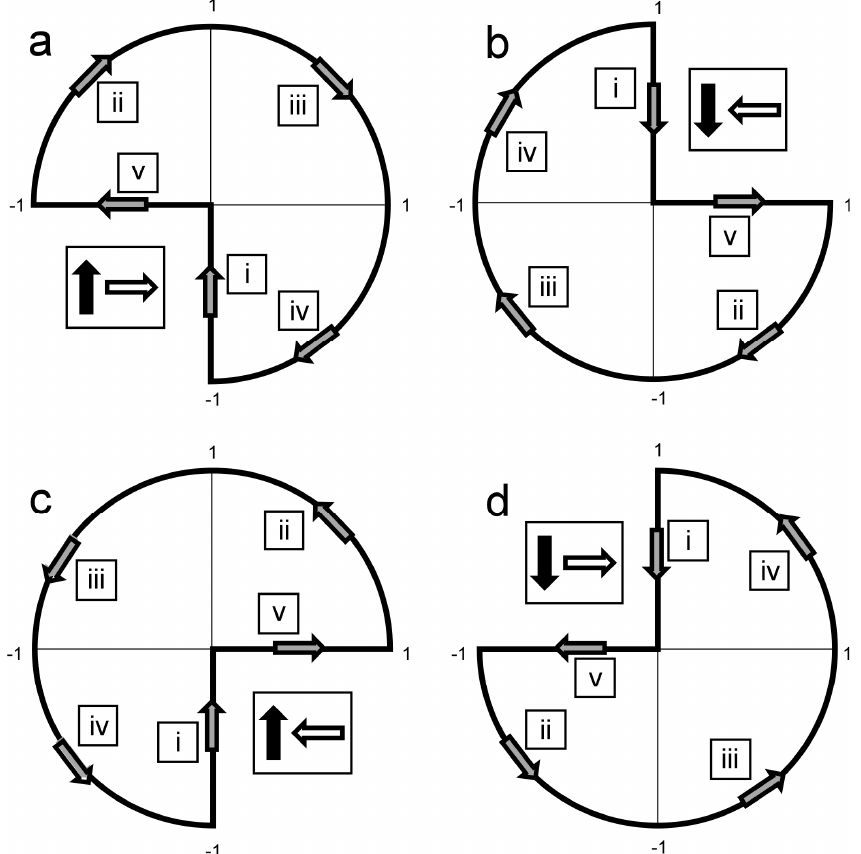
Figure 8. A reconstruction of the effective electric field created from the combined operation of the two perpendicular coils, for the four rfTMS polarity states. The field of coil #1 is directed along the y -axis (anterior-posterior) and the field of coil #2 along the x -axis (lateral-medial). The effective field completes 3/4 of a full cycle during the magnetic pulses, as indicated by the gray arrows. The Latin numbers in squares indicate the order of evolvement of the field vector during the pulses. The polarities were induced such that during the second stroke of the biphasic pulse by the lower and upper coils the induced current in the brain was P-A and L-M (left-right on the left hemisphere) ( ↑→ , panel ( a )), A-P and M-L ( ↓← , panel ( b )), P-A and M-L ( ↑← , panel ( c )), or A-P and L-M ( ↓→ , panel ( d )), respectively. The black and white arrows represent the polarity induced during the second stroke of the biphasic pulse by the lower and upper coils, respectively. (Reproduced from [30].)